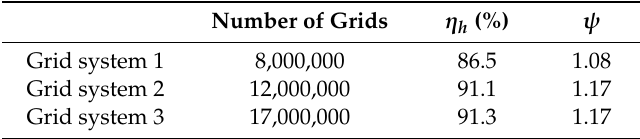
Figure 6. Planes for data analysis ( a ) The middle spanwise hub-to-shroud surface and ( b ) the guide vane symmetry plane. Table 2. η h and H at BEP of the optimum GVO in the three grid systems.